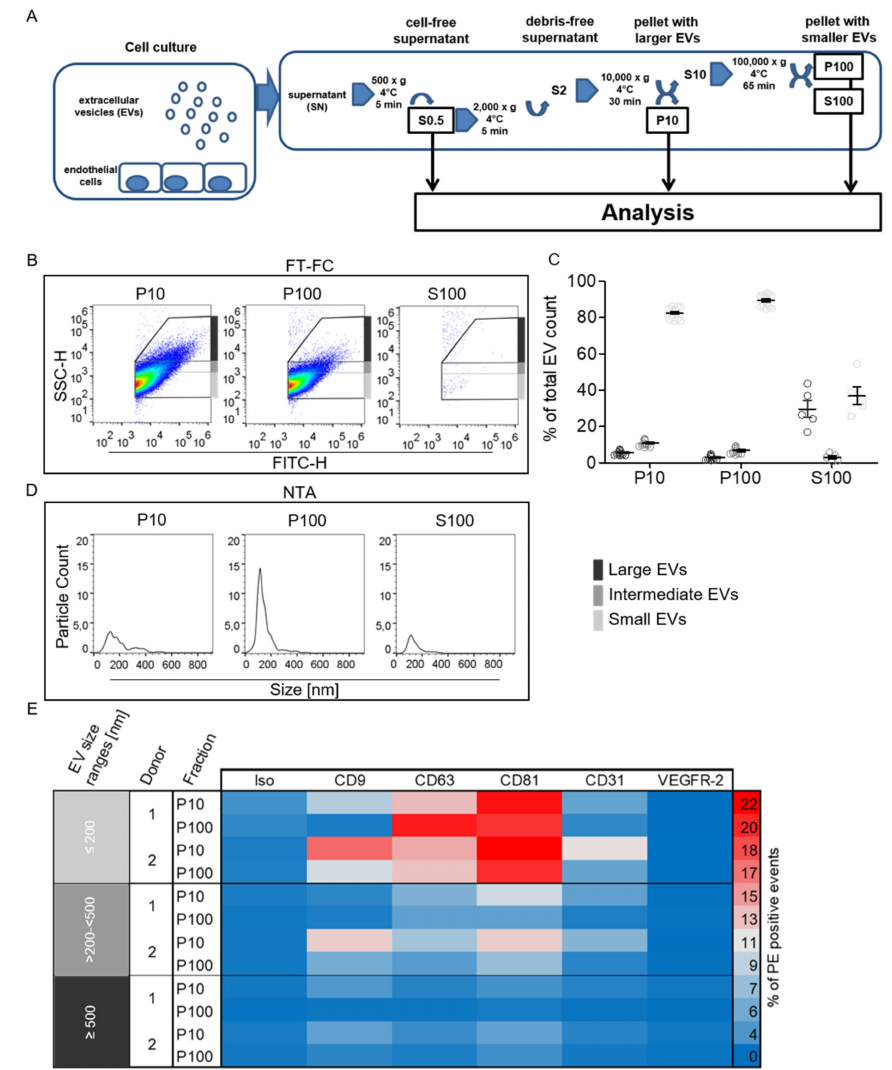
Figure 3. Distinct characteristics of human umbilical vein endothelial cell derived extracellular vesicles EVs. ( A ) The obtained cell culture supernatants (SN) were cleared from debris and large particle conglomerates via centrifugation at 500 and 2000 × g for 5 min each. The cleared SN (S0.5) was used to analyze total particle and extracellular vesicle (EV) count via scatter and fluorescence mode nanoparticle tracking analysis (NTA). Their total size distribution was assessed via fluorescence-triggered flow cytometry (FT-FC). The large and denser subfraction of EVs was obtained by centrifugation for 30 min at 10,000 × g (P10). Small and less dense EVs were enriched by ultracentrifugation for 65 min at 100,000 × g (P100). Both subfractions were analyzed via FT-FC to obtain information on the respective surface marker composition. The remaining supernatant after the di ff erential centrifugation procedure (S100) was analyzed for particle and EV count in order to check the e ffi ciency of the enrichment. ( B )